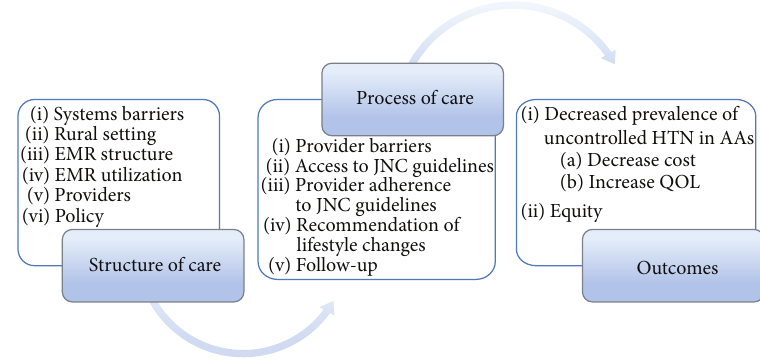
Figure 1: Application of Donabedian’s quality of